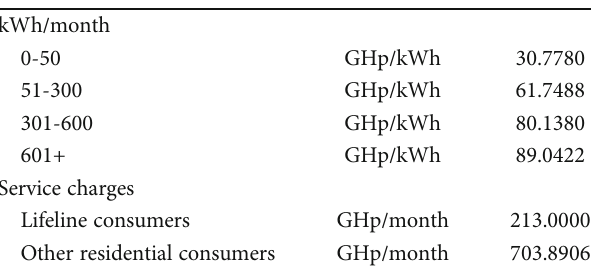
Figure 4: Total electricity generation and excess from the 3kWp solar PV systems. Table 4: End user electricity tari ff s.